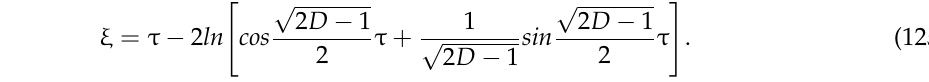
Figure 5. Variations in creep strain ε ( a ) and reduced strain rate normalized time τ at a critical value of applied stress a = a* ( D =